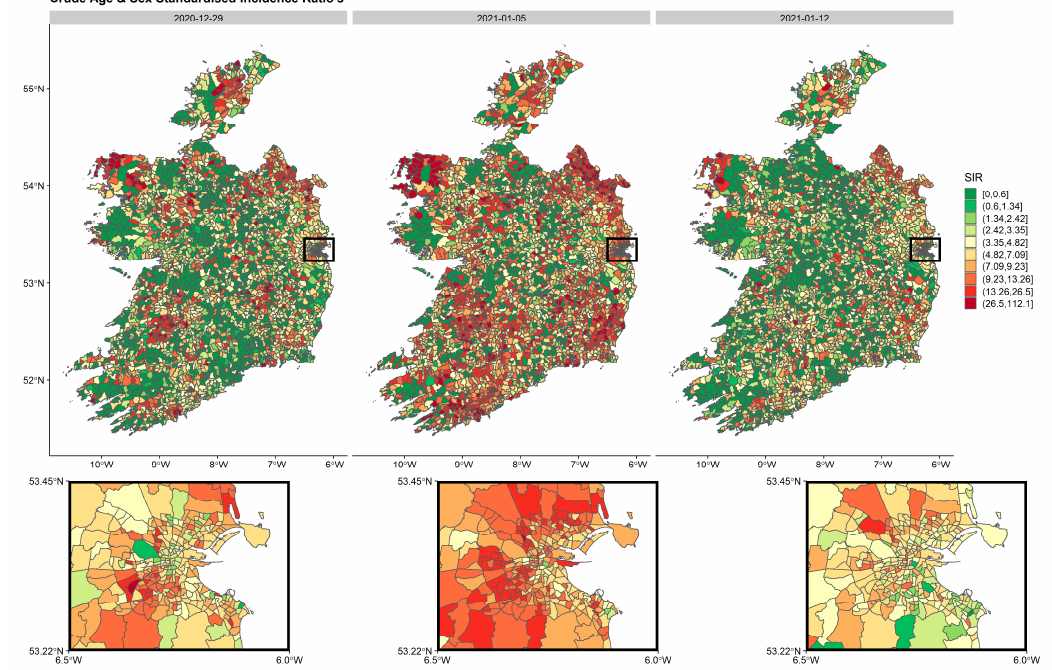
Figure 3. Age- and sex-standardised incidence ratios’ (SIRs) by week per ED in Ireland during the second three weeks of wave 3 (29 December 2020–12 January 2021). The inset represents the greater Dublin area (capital of Ireland), where EDs are generally smaller in geographical size due to larger populations. The maps are standardised to the whole pandemic.